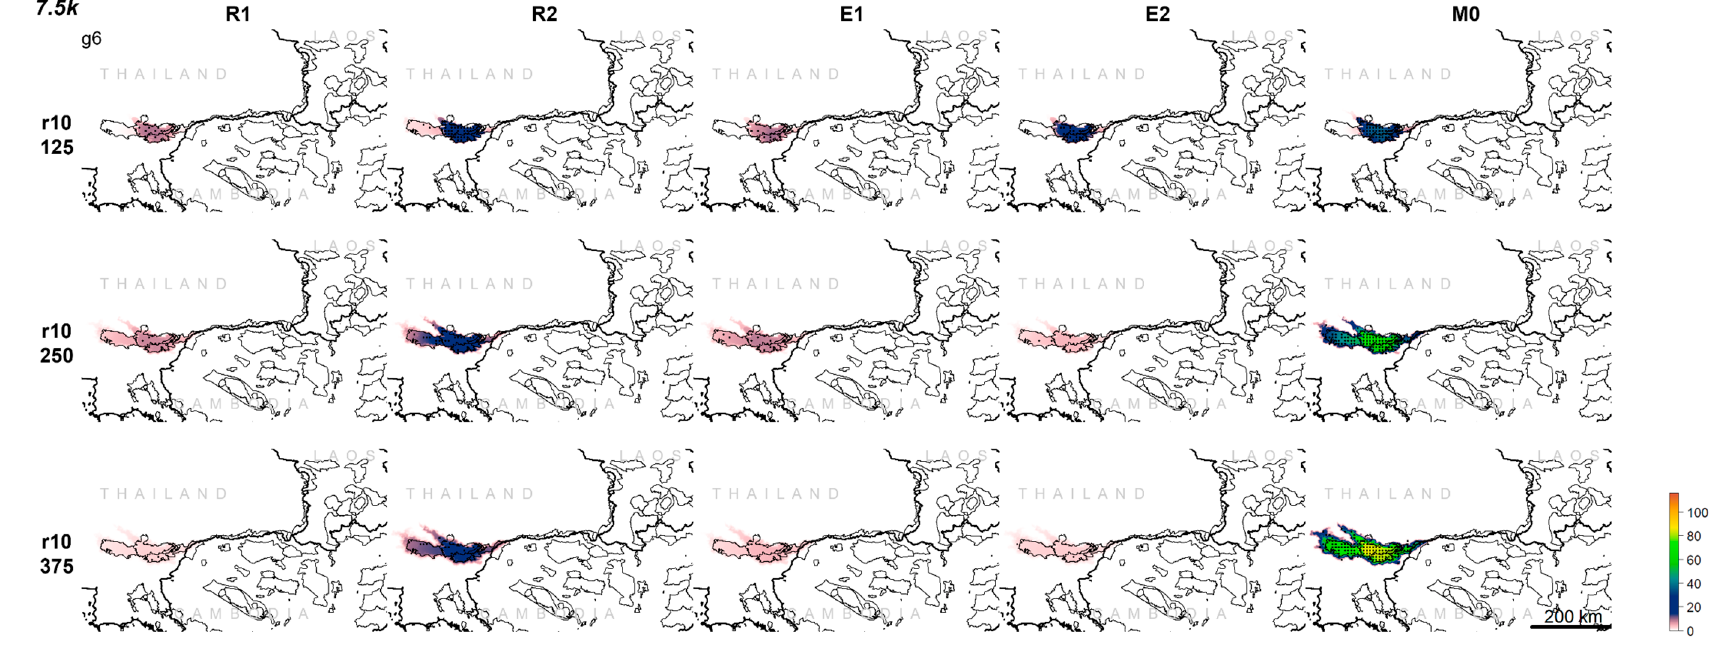
Figure 3. Sample maps demonstrating divergence in cumulative resistance kernels and populations between combinations of mortality function (MORT—R1, R2, E1, E2, and M0) and dispersal ability (KERN—125 kcu, 250 kcu, and 375 kcu) at timestep 6, holding highway mitigation scenario (SCEN—S3), territory spacing (DENS—7.5 km), and resistance transformation (RES—r10) constant. Values reflect the expected cumulative density of dispersing individuals from each source point. Additional maps and timestep animations can be found in Supplementary Materials 3, Tables S1–S6.